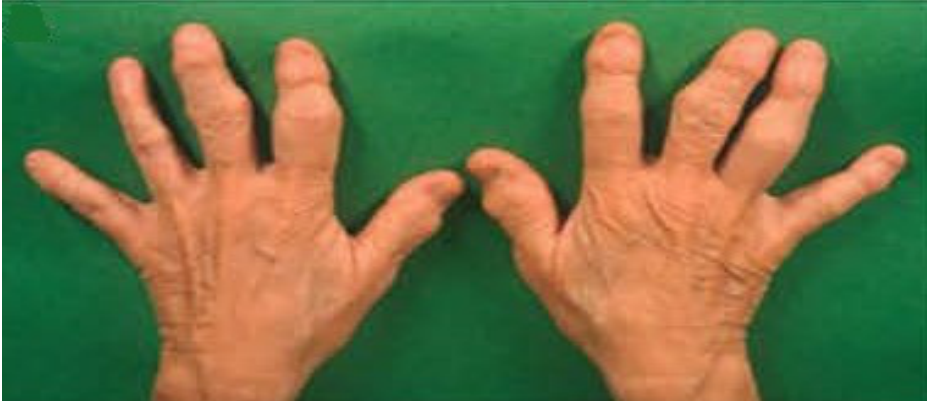
Figure 1. Digital nerve loss protects against arthritis-induced joint destruction. Swelling and joint deformity exist for distal and proximal interphalangeal joints except for the fourth digit in a patient suffering from long-standing psoriatic arthritis. She had previously suffered a complete traumatic transection of the fourth digital nerve as a child, before the onset of arthritis, which had resulted in sensory denervation (Reproduced from Kane et al. [4] ).